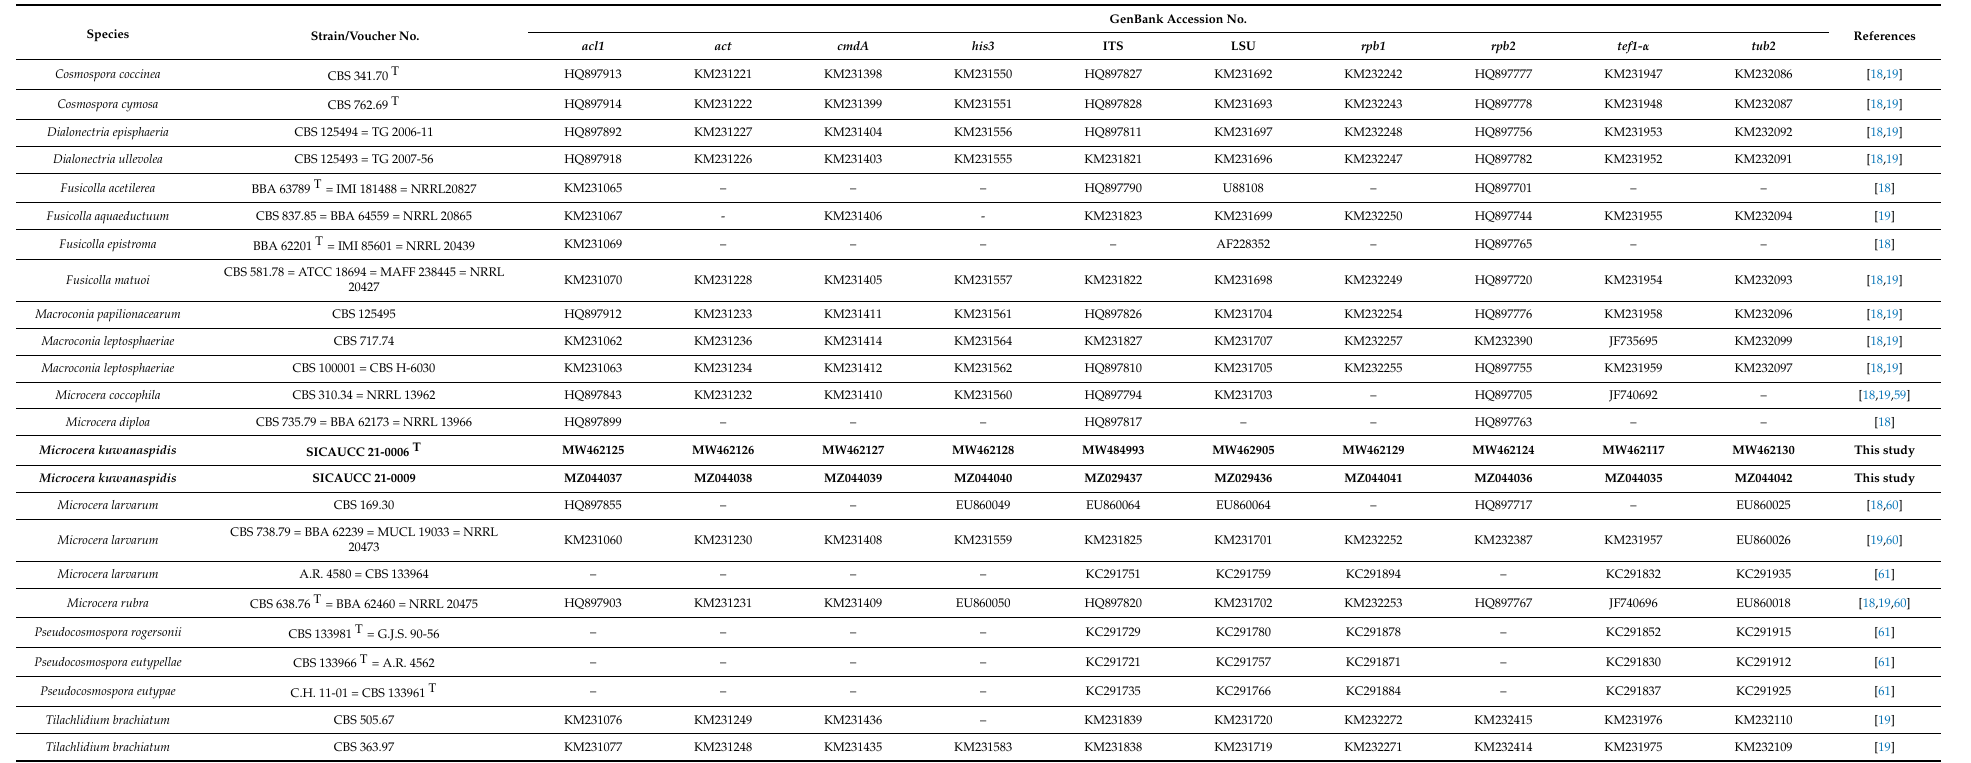
Table 2. GenBank accession numbers of strains in Nectriaceae used for the phylogenetic analyses of Microcera